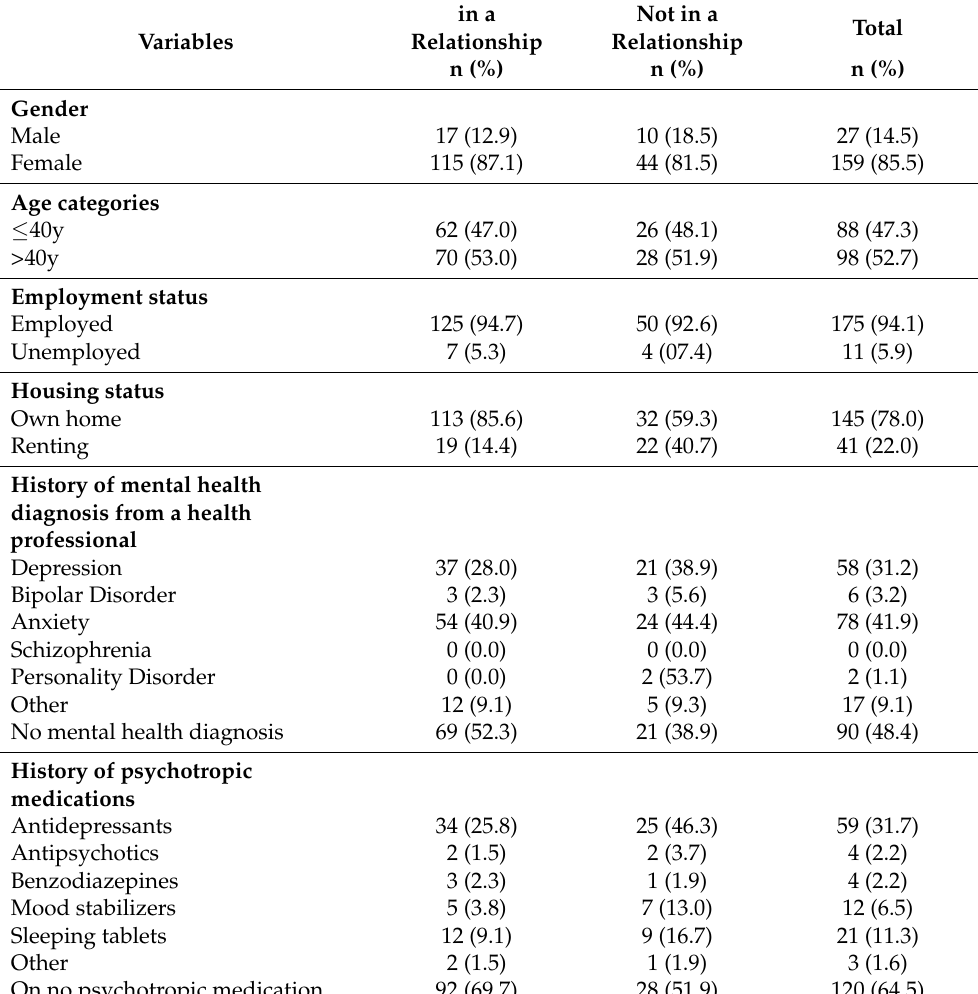
Table 1. Demographic profile, clinical characteristics, and support received by the study